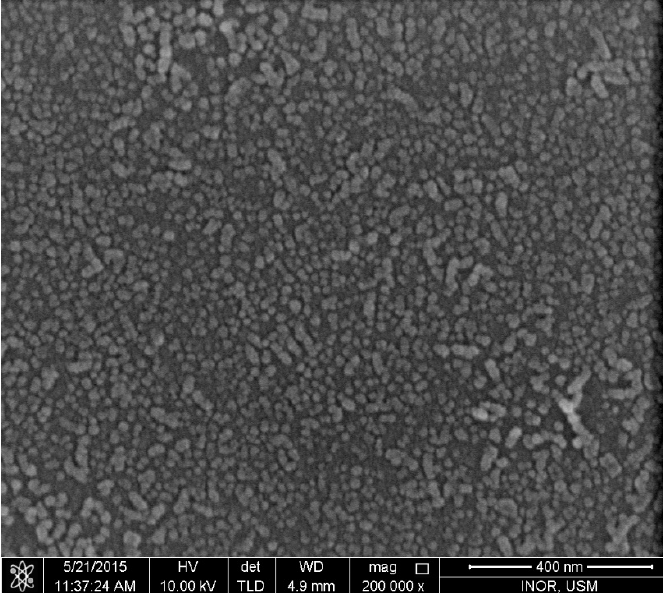
Figure 3. The ZnO nano-seed layer deposited on glass substrates before fabricating ZnO nanorods (NRs) on it.